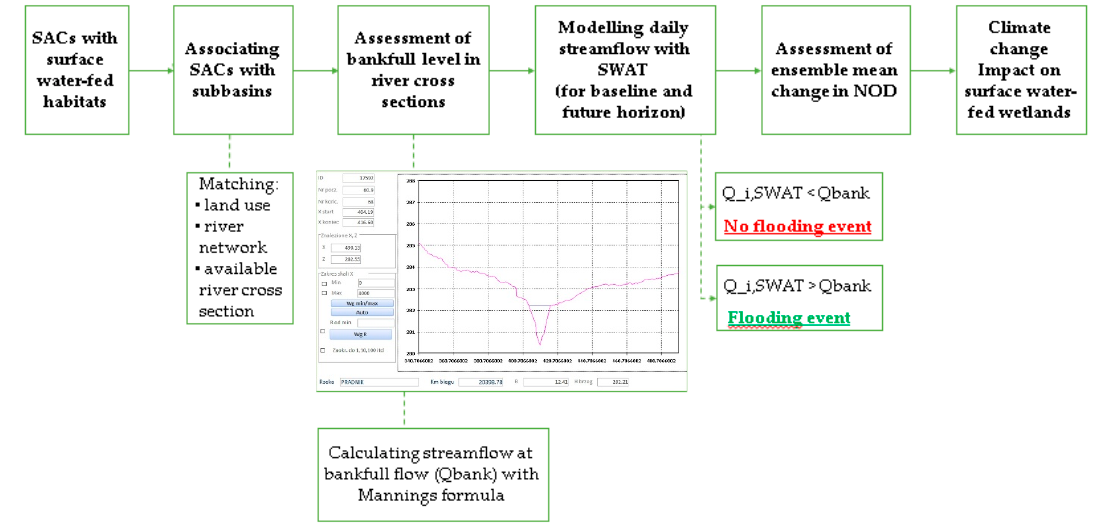
Figure 2. Scheme of the analysis procedure for surface water-fed wetlands, where Q_i,SWAT is the streamflow obtained from SWAT model and Qbank is the bankfull flow at a given cross-section; the NOD is a yearly number of days when streamflow exceeds bankfull flow.